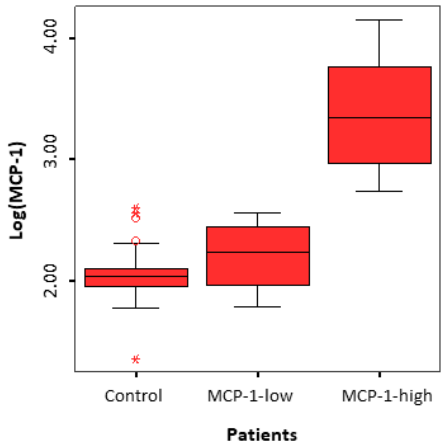
Figure 4. MCP-1 levels (following Log transformation) in the follicular fluid of patients with endometriosis (MCP-1-low and MCP-1-high subgroups) and controls.